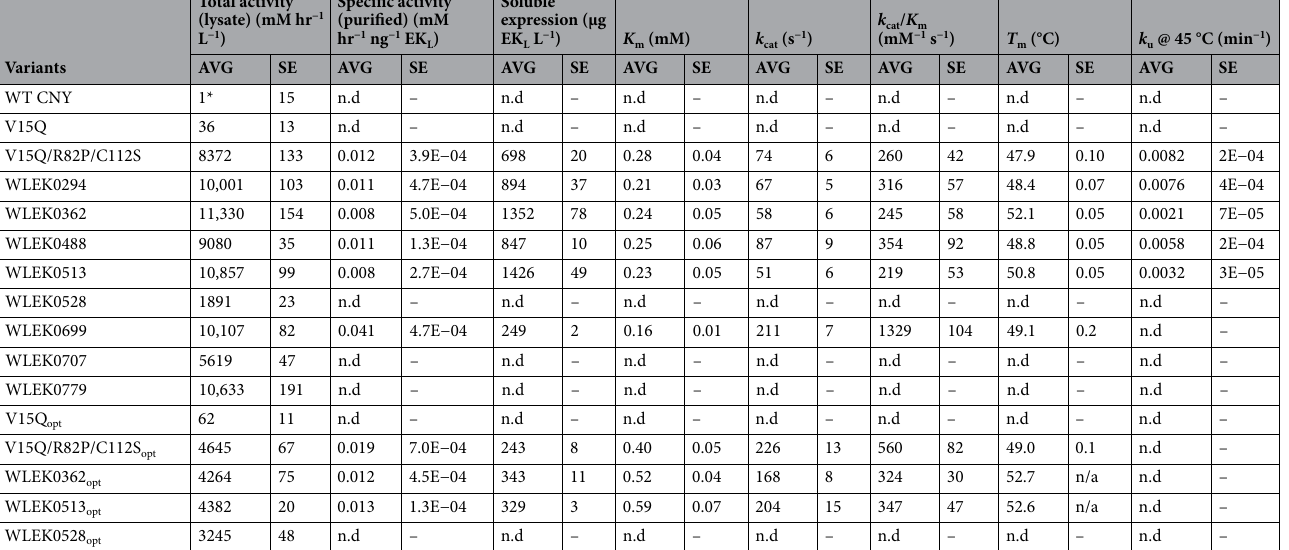
Table 3. Characterisation of EK L variants expressed at 37 °C. Total activity in clarified lysates and specific activity for purified enzyme were each assayed using 0.0625 mM substrate. Soluble expression = Total activity/ Specific activity. n.d.—no data. * WT activity is rounded up to 1, but the limit of detection was approx 15 mM hr −1 L −1 .